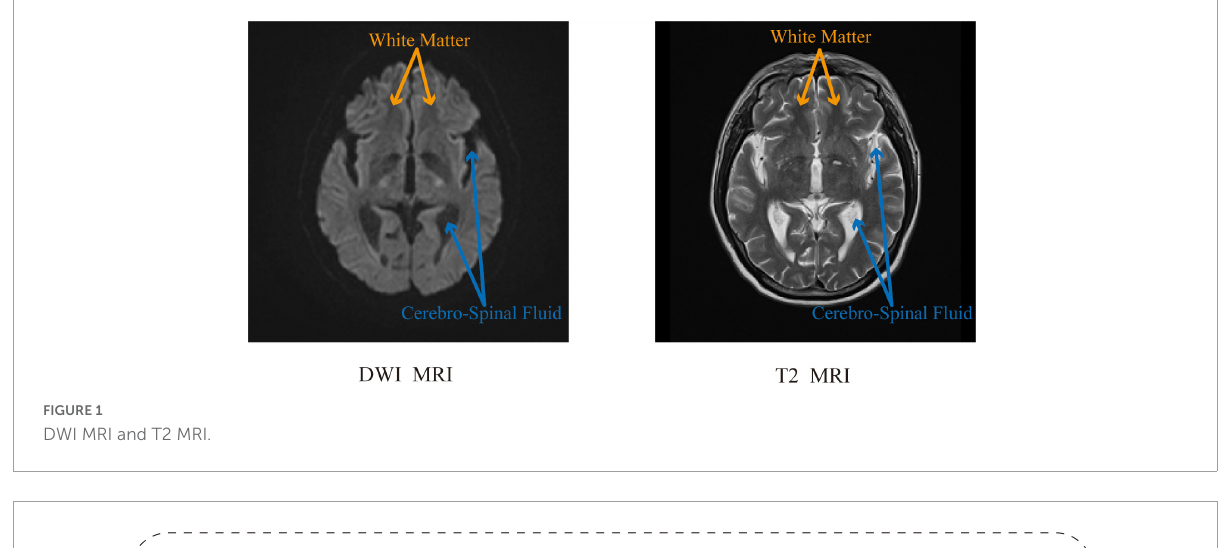
FIGURE1 DWI MRI and T2 MRI.